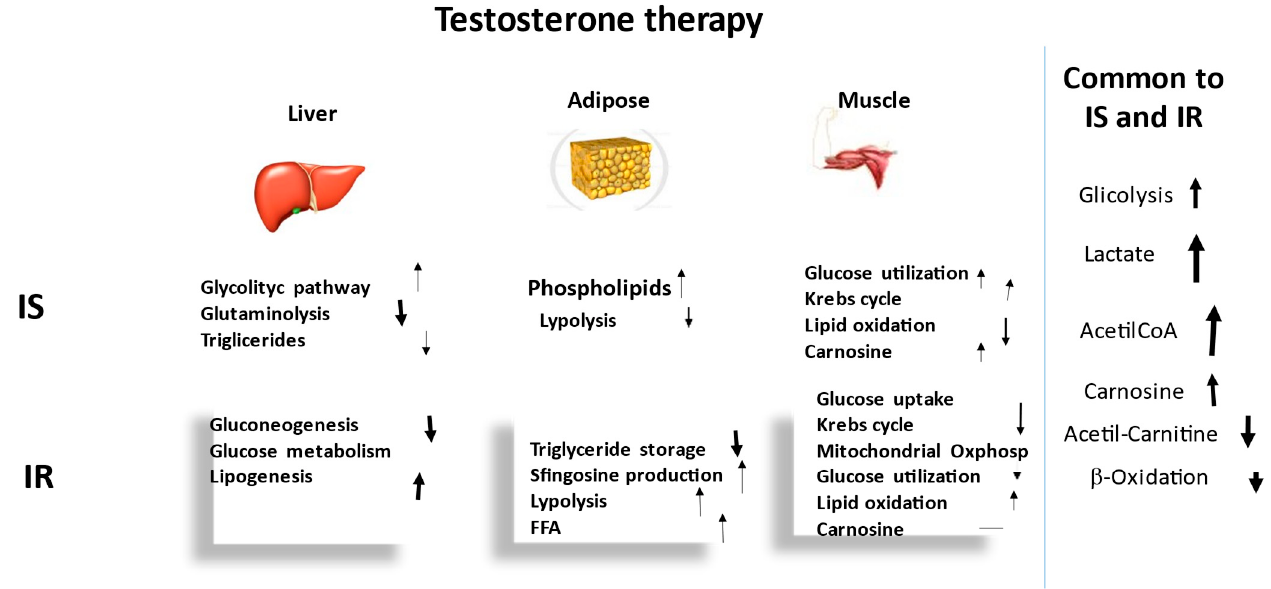
Figure 5. Schematic representation of the metabolisms affected by testosterone therapy in the three main tissues. Boxes report metabolisms notoriously altered by testosterone therapy (increased or decreased). The size of arrow indicates the intensity of the change. 4. Discussion The data reported indicate that, in the case of testosterone deficiency in IS hypogonadism, glycolysis and glutaminolysis produce energy, probably due to the fact insulin increases ATP and NADH levels and promotes glutaminolysis. In IR, instead, the main source of energy is gluconeogenesis, fueled by amino acids, branched-chain amino acids in particular, and the malate–aspartate shuttle [53,54]. However, comparisons revealed that, upon TRT, not all metabolisms were completely restored, and metabolic re- programming was observed in both IS and IR. The TCA cycle was partially restored in both cases, but ATP levels as well as NADH production were low, indicating that testosterone therapy did not resolve the energy supply through canonical pathways. Lactate and acetyl-CoA increased in both IS and IR upon TRT. In IS, the reactivation of GLUT4 in muscles induced the activation of an anomalous glucose–lactate cycle, where alanine was excluded from the cycle [53]. This activation included the participation of glucose, which is possible in these patients thanks to insulin still being active. The